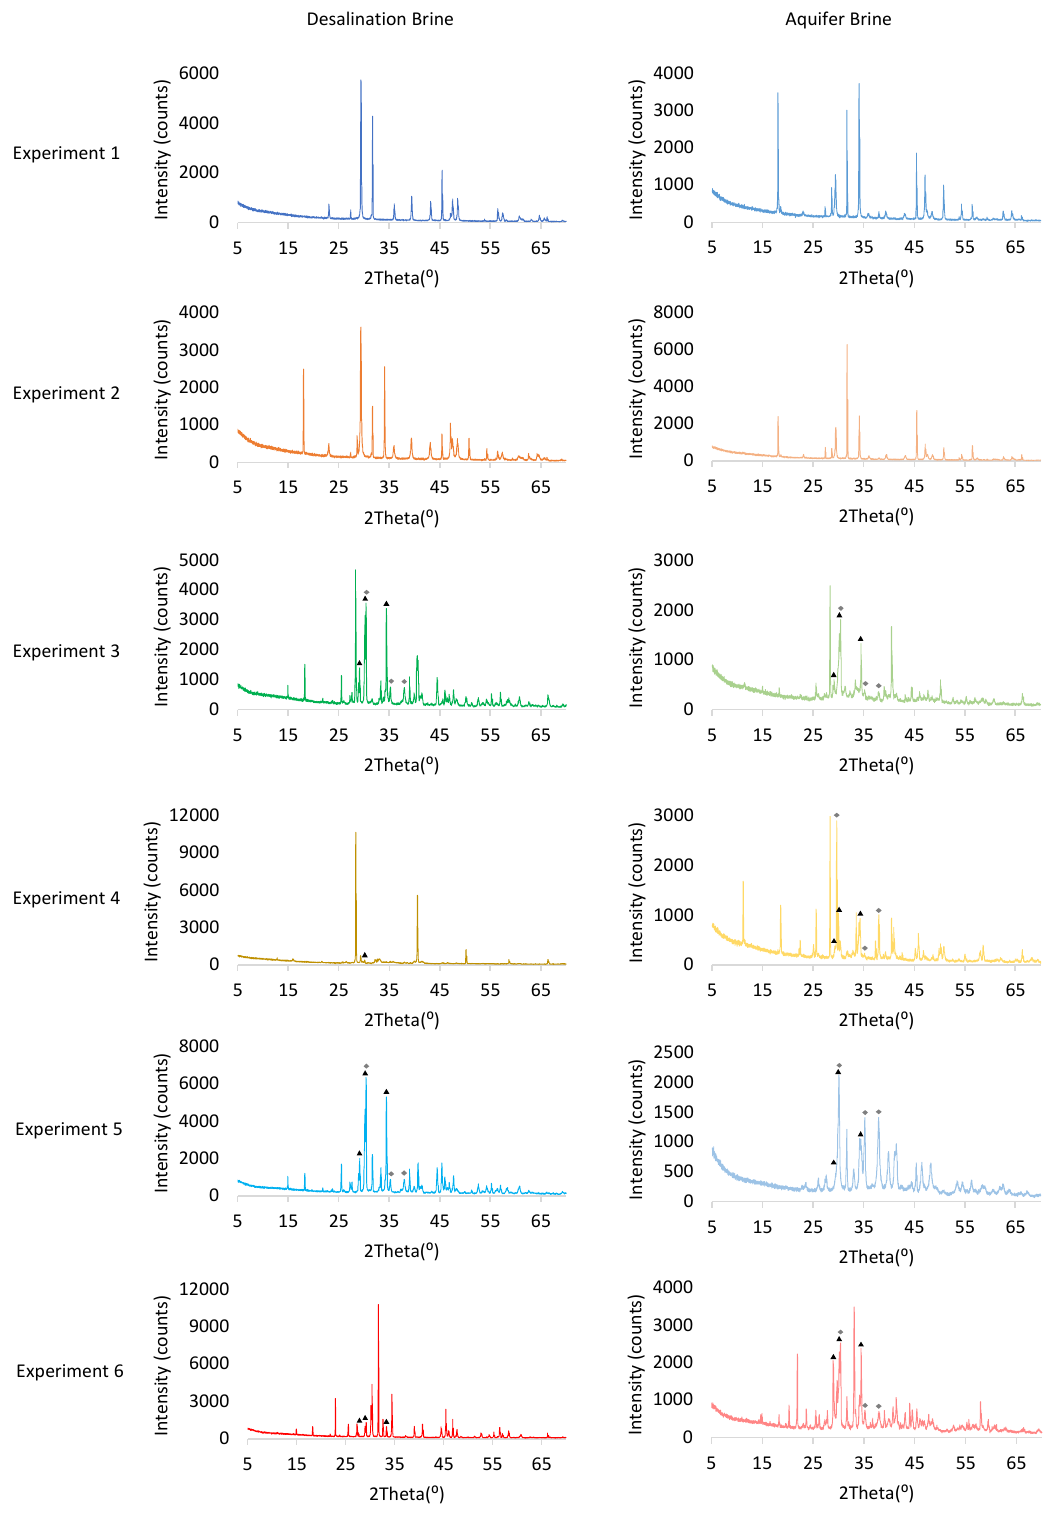
Figure 2. XRD diagrams of the solid products obtained from the six carbonation experiments performed using both the desalination unit and the aquifer brine, respectively. The three main peaks of the target minerals, nahcolite (black triangles), and natrite (grey diamonds) are indicated.